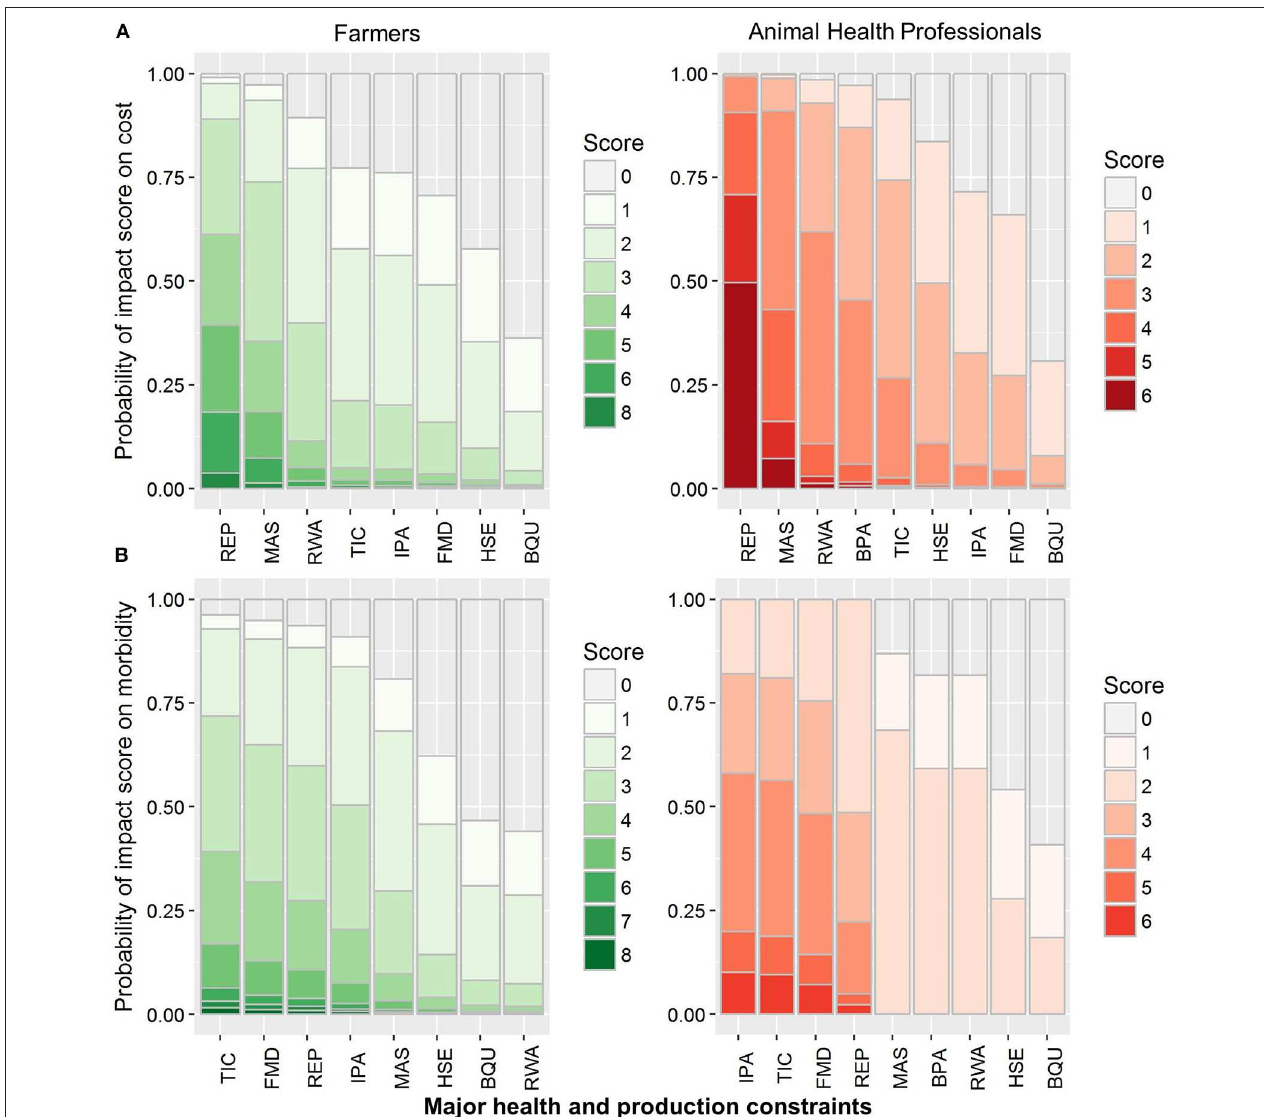
FIGURE 4 | Grouped stacked bar plot of logistic regression of probability impact score on the cost of production (A) and morbidity caused by health and production constraints (B) in cattle and buffaloes perceived by small-scale dairy farmers and animal health professionals in Pakistan. Major bovine health and production constraints include blood parasites (BPA), blackleg (BQU), foot-and-mouth disease (FMD), hemorrhagic septicemia (HSE), internal parasites (IPA), mastitis (MAS), Redwater (RWA), reproductive disorders (REP), and ticks